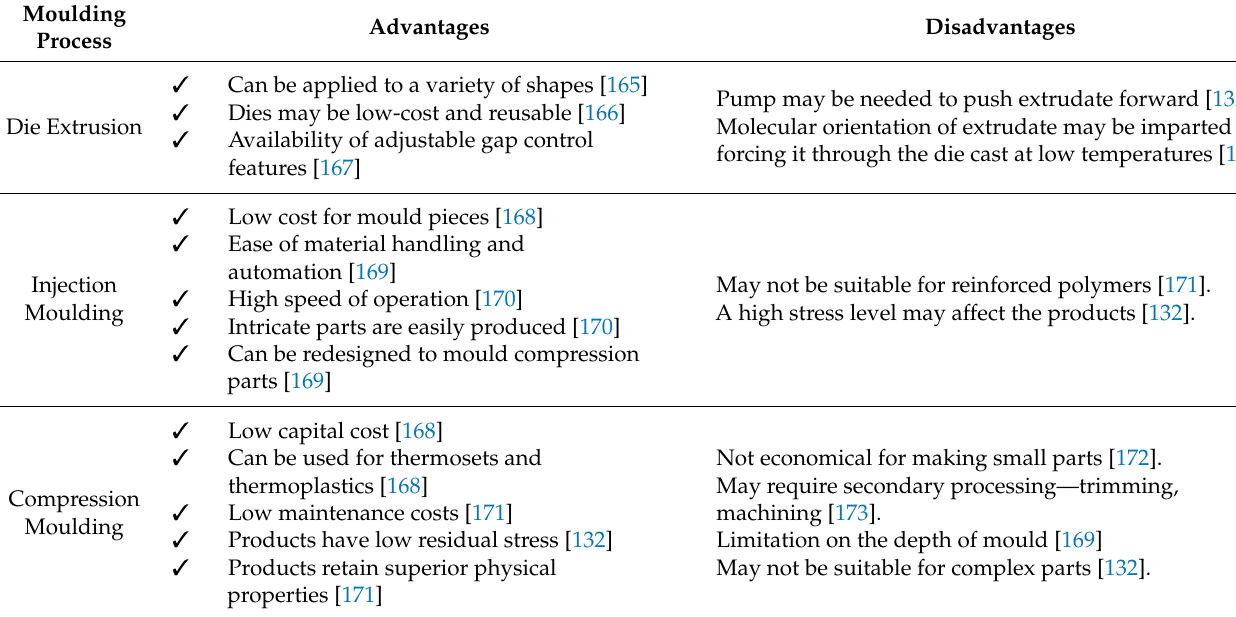
Table 4. Advantages and disadvantages of die extrusion, injection, and compression